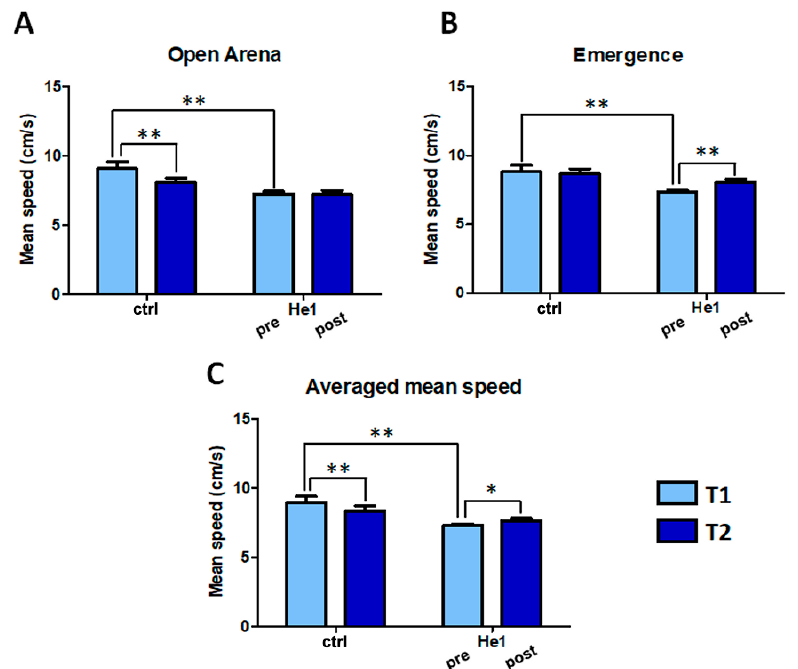
Figure 2. H. erinaceus treatment reverted the mean speed decline during senescence. Mean speed (cm/s) estimated during open arena test (Panel A ) and emergence task (Panel B ). Panel C : Averaged mean speed, calculated between mean speed obtained in open arena and emergence tests in untreated and He1 treated mice before (T1) and after (T2) treatment. Two-way ANOVA was performed for statistical analysis: * p < 0.05; ** p < 0.01.